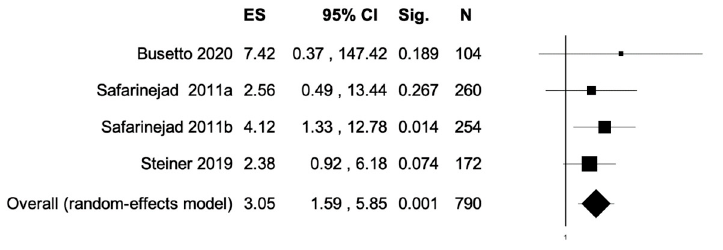
Figure 2. Forest plot showing the OR for nausea. ES, effect size; CI, confidence interval. (I2 = 34.81, p = 0.150).